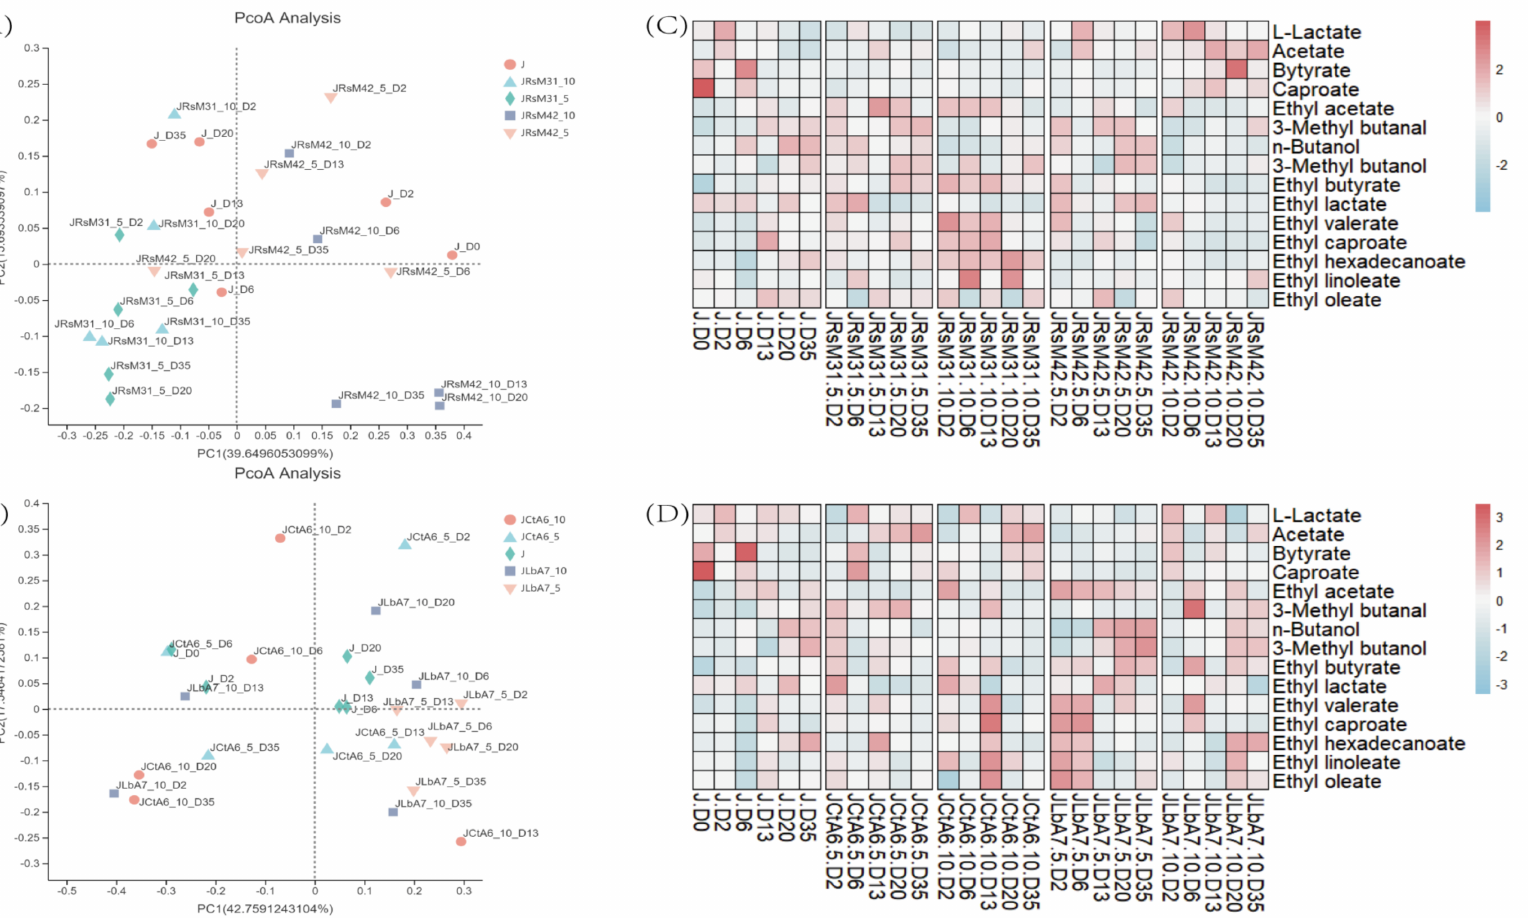
Figure 3. Effect of functional microorganisms on major flavor substances during liquid fermentation. Figure ( A , B ) were principal co-ordinates analysis of RsM31, RsM42, CtA6 and LbA7 fermented in zaopei, in the figures J represent zaopei without inoculation; “5 and 10” meant 5% and 10% inoculation amount during fermentation; “D0, D2, D6, D13, D20, D35” represent fermented days. Figure ( C , D ) were heat map of flavor substances in solid fermentation of functional microorganisms inoculated zaopei, in the figures the redder the boxes, the higher the substances content, and the bluer the boxes, the lower the substances